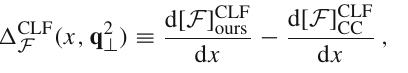
, D ∗ ) , B → ( B ∗ , B ∗ ) transitions c s 2 s 2 2 2